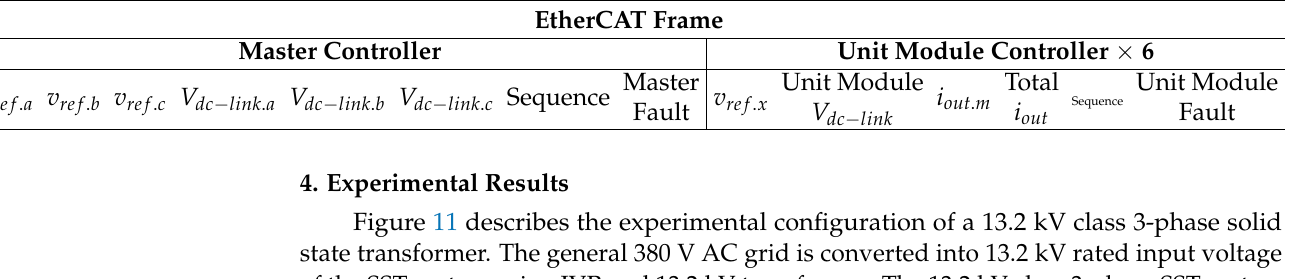
Figure 10. The proposed entire control strategy for a 13.2 kV class 3-phase solid state transformer using EtherCAT communication. Table 4. EtherCAT data frame configuration of a 13.2 kV class 3-phase solid state